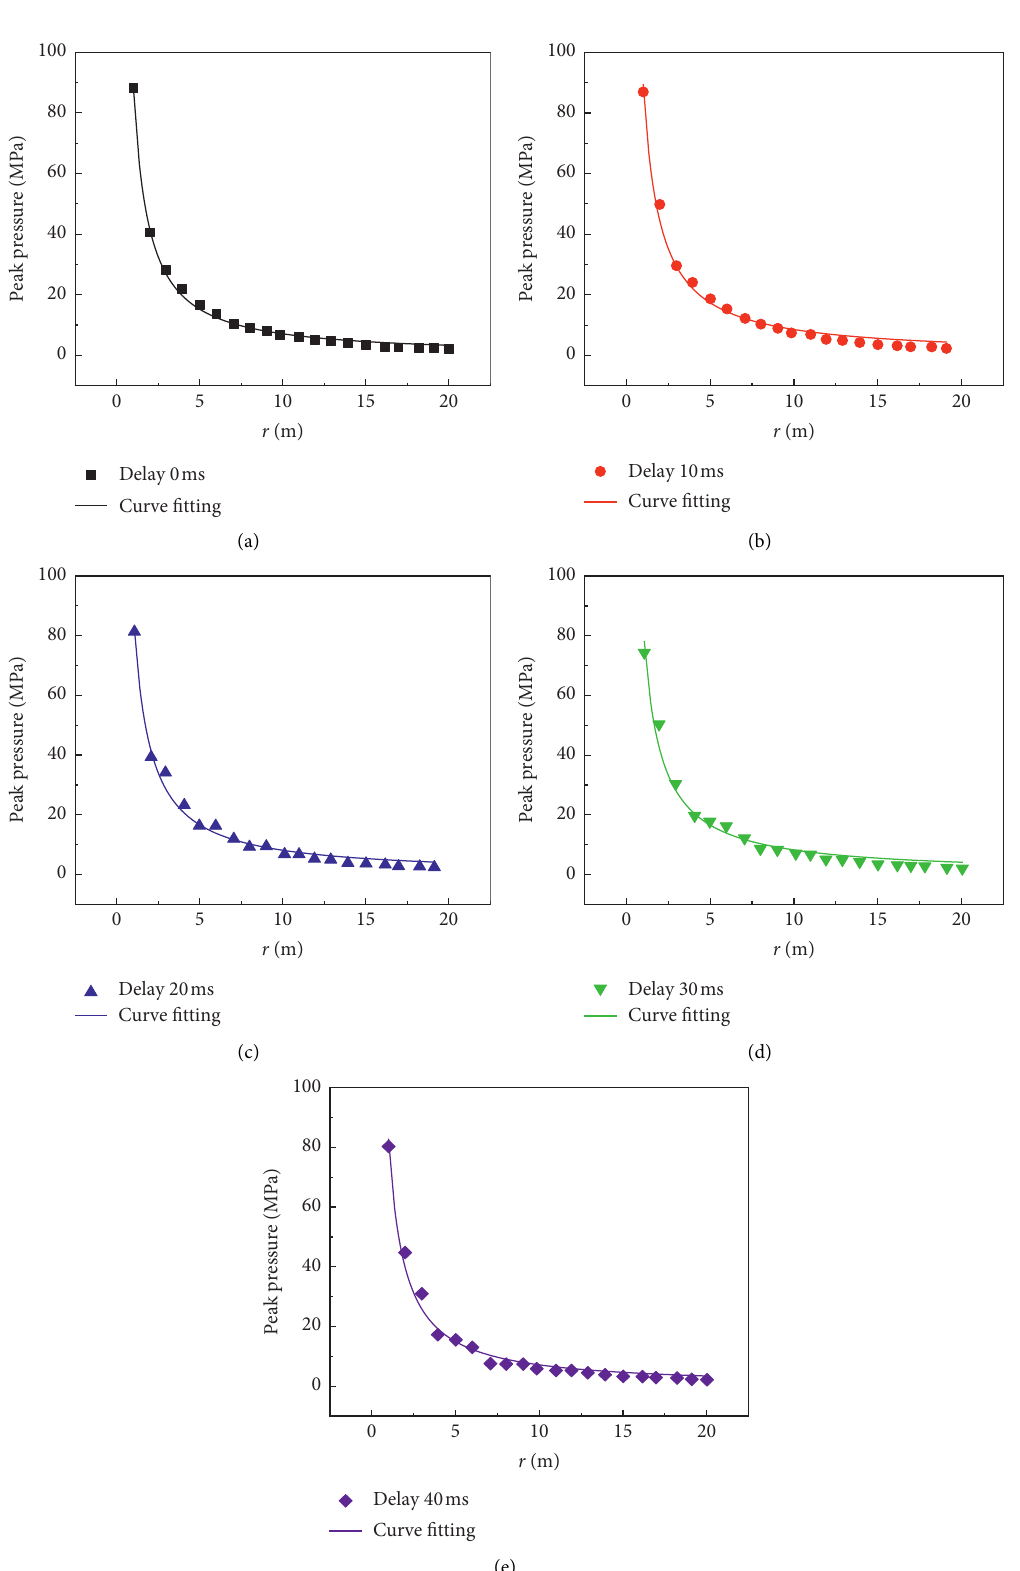
Figure 6: The attenuation curve of water hammer wave on the minimum resistance line. (a) Delay 0 ms fitting curve. (b) Delay 10ms hole blasting fitting curve. (c) Delay 20ms fitting curve. (d) Delay 30 ms hole blasting fitting curve. (e) Delay 40ms hole blasting fitting